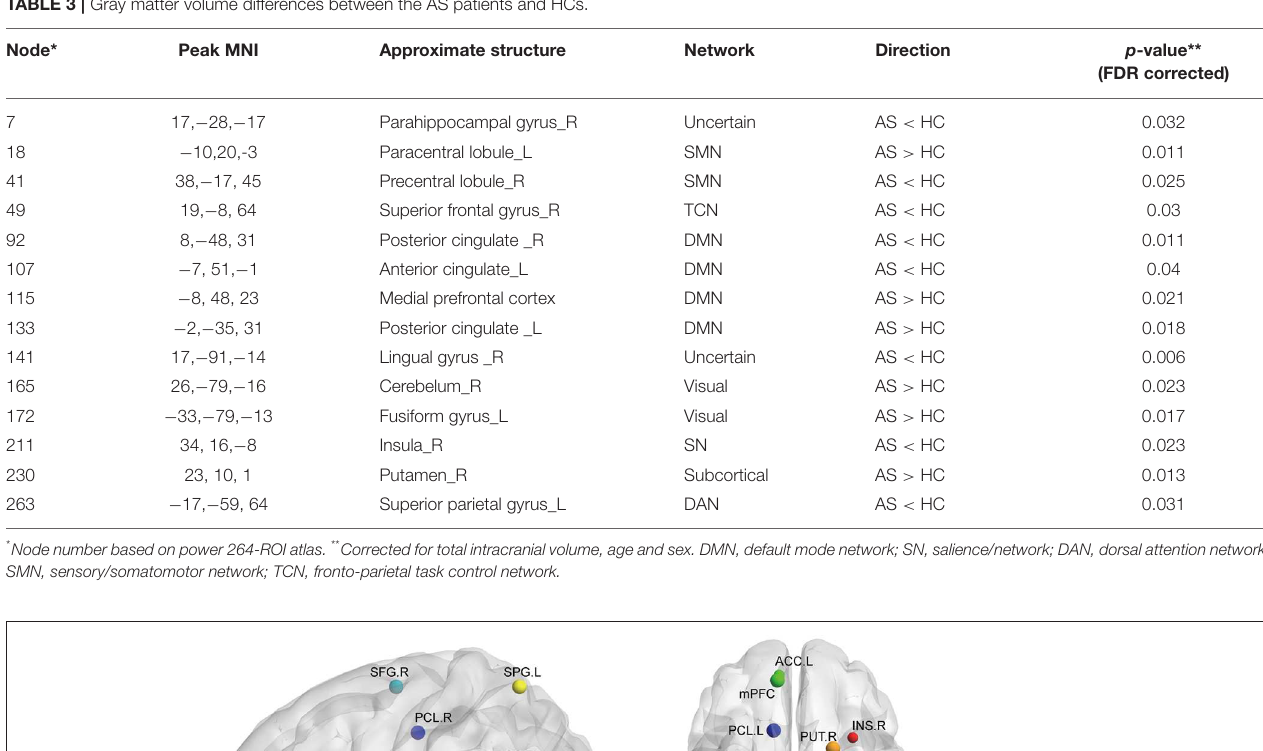
formation between neurons. The increased SC between left